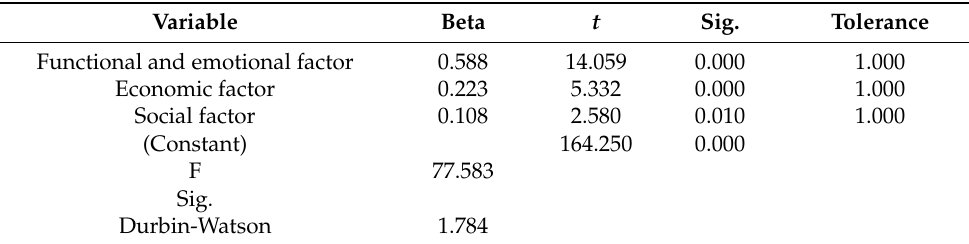
Table 5. Relationship of perceived value and saying positive things about the destination.